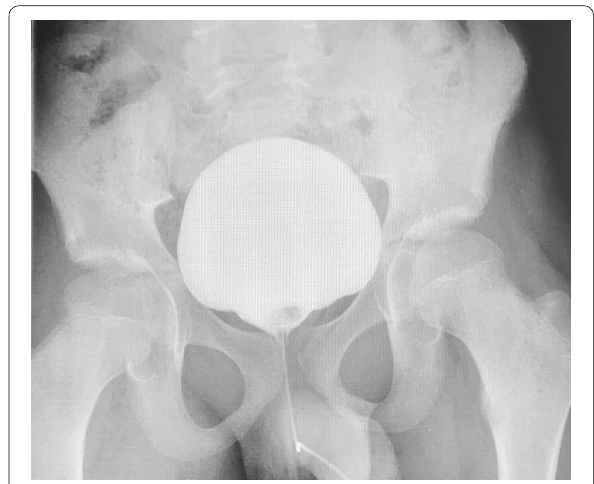
Fig. 1 Voiding cysto-urethrogram post-initial bladder repair